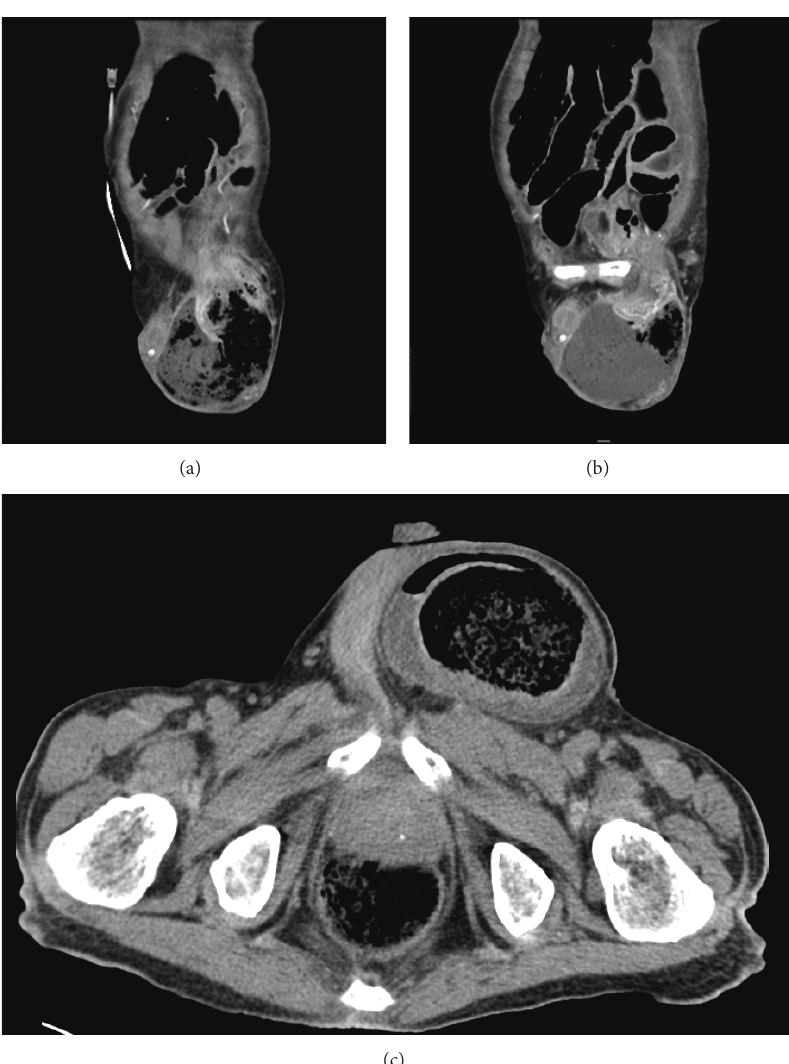
Figure 1: The transverse colon was incarcerated in the left inguinal canal (a, b). Free air and air-fluid level were observed around the transverse colon, suggestive of a perforation